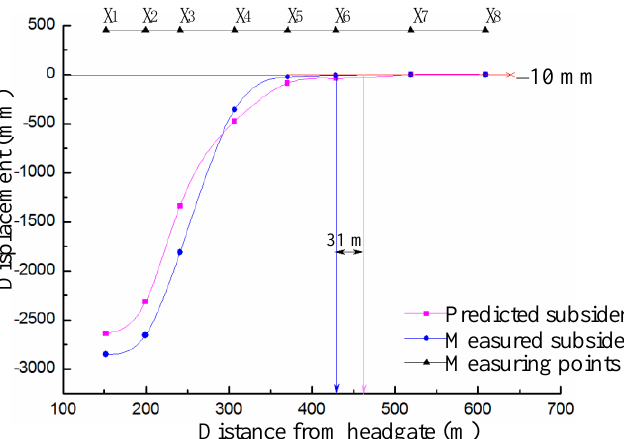
Figure 17. Comparison of predicted and measured values of line X.